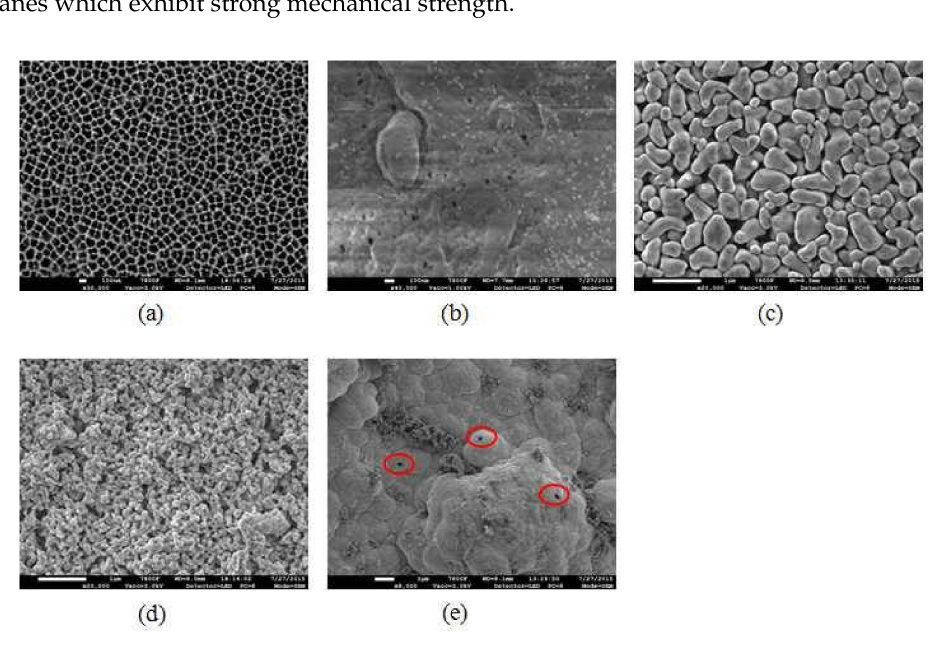
Figure 10. FESEM images: ( a ) 100 nm Anopore TM membrane; ( b ) 80 nm PVDF membrane; ( c ) 30 nm single tubular ZrO 2 / γ -Al 2 O 3 / α -Al 2 O 3 membrane (outer surface); ( d ) 100 nm multichannel tubular ZrO 2 / γ -Al 2 O 3 / α -Al 2 O 3 membrane (inner surface); ( e ) defects of dense Pd composite